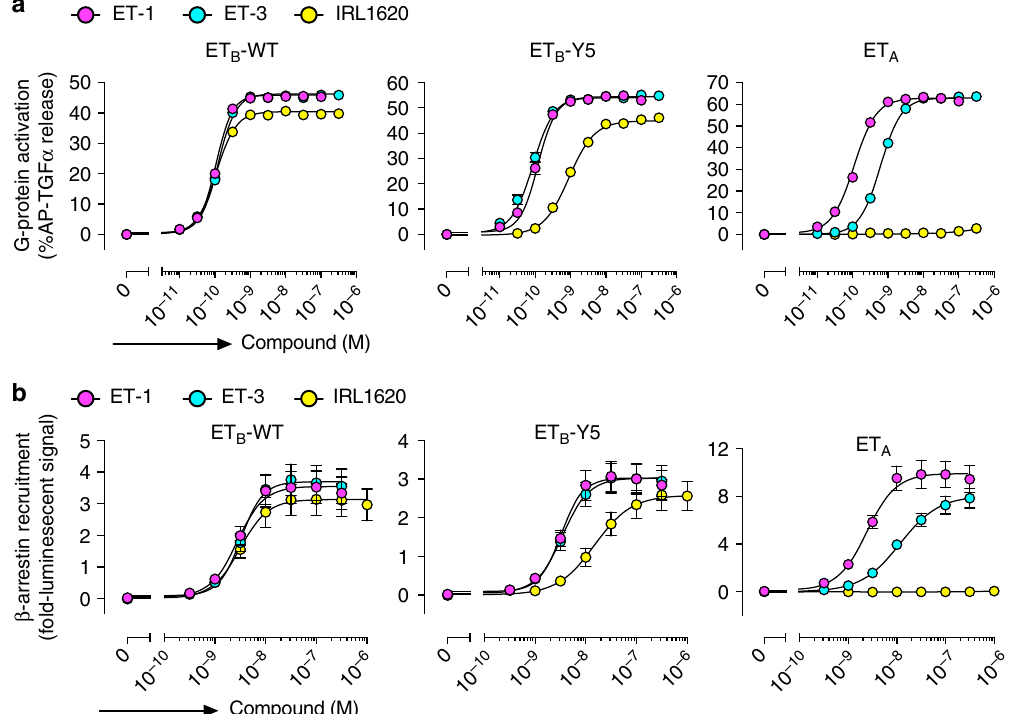
Fig. 1 Pharmacological characterizations of ET-3 and IRL1620. a Concentration-response curves of AP-TGF α release in the ET-1, ET-3, and IRL1620 treatments of HEK293 cells expressing the indicated endothelin receptors. Symbols and error bars are means and s.e.m. (standard error of the mean) of fi ve or seven independent experiments, each performed in triplicate. Note that the error bars are smaller than the symbols for most data points. b Concentration – response curves of β -arrestin recruitment in the ET-1, ET-3, and IRL1620 treatments of HEK293 cells expressing the endothelin receptors. Symbols and error bars are means and s.e.m. of four independent experiments, each performed in